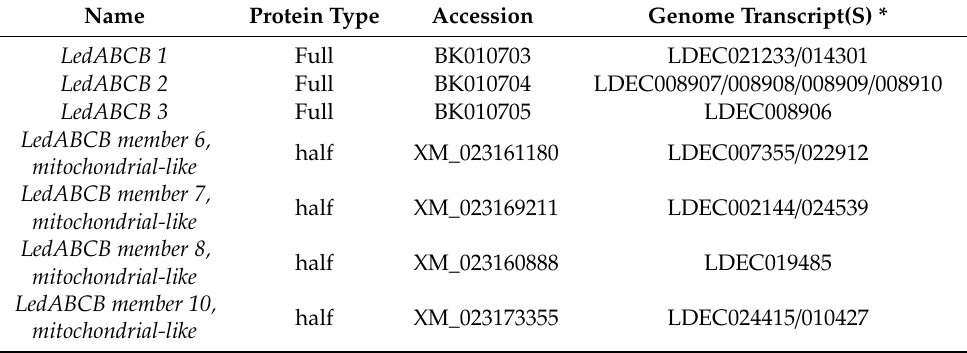
Table 2. Potential MDR genes (ABCB subfamily) identified in the L. decemlineata